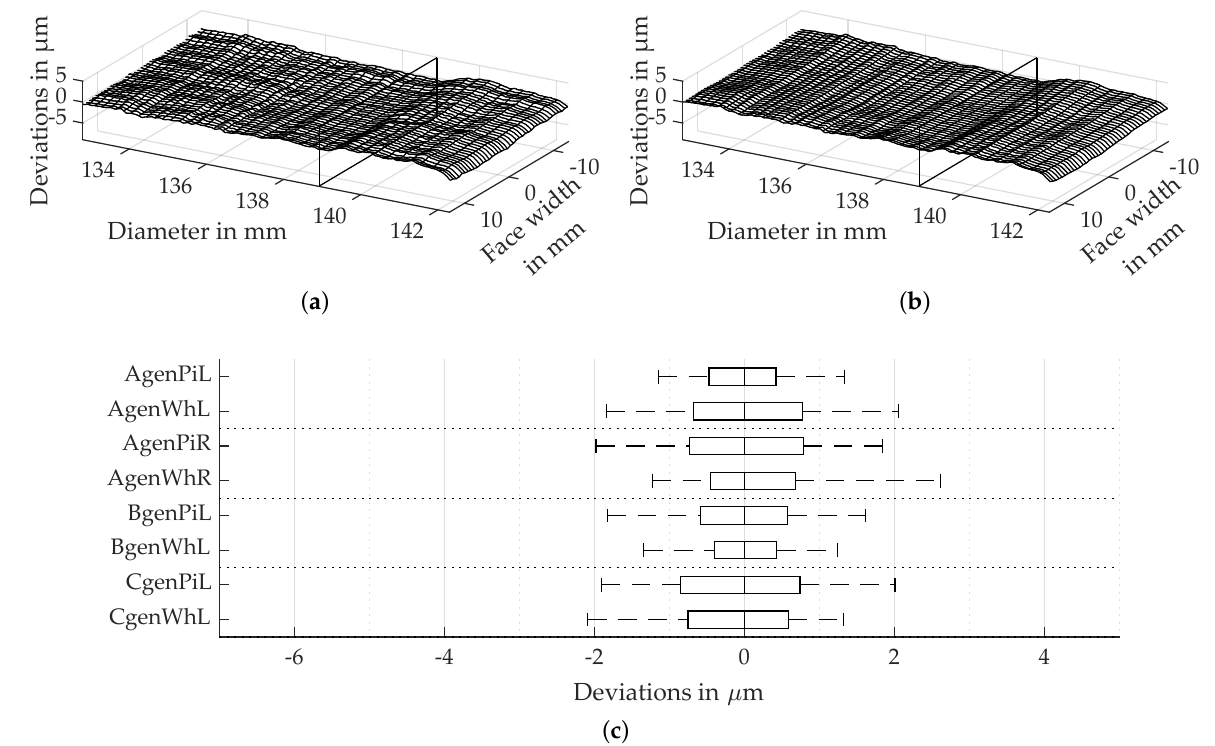
Figure 10. Deviations for continuous generating grinding. ( a ) Flank of gear AgenPiL at tooth nr. 34. ( b ) Median of all teeth of gear AgenPiL. ( c ) Box plot of the deviations in the gear